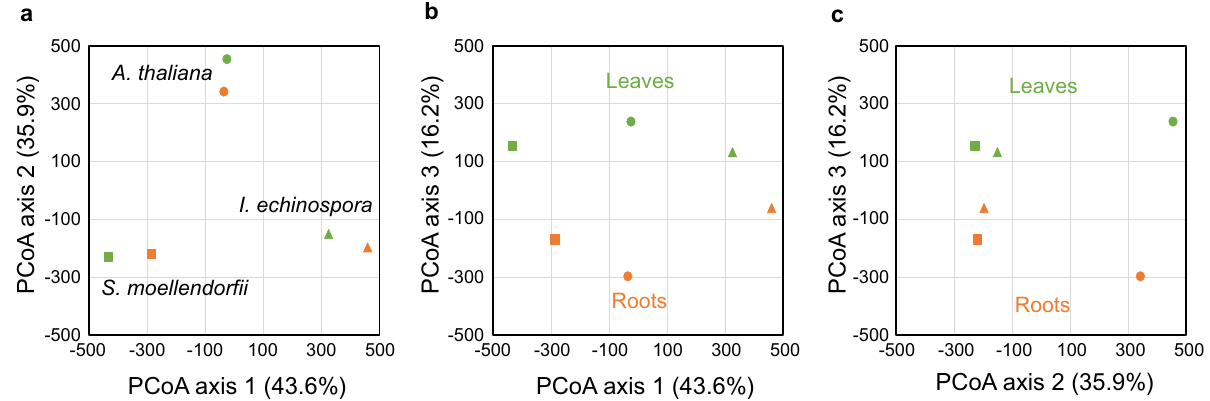
PCoA axis 1 (43.6%) Figure 3. Comparison of root and leaf transcriptomes of Arabidopsis thaliana , I. echinospora and Selaginella moellendorffii . Comparison of gene expression profiles by PCoA in the transcriptomes of A. thaliana, circles, S. moellendorffii, squares and I. echinospora, triangles. Leaf samples coloured green, root samples orange. ( a ) comparison of principal coordinate axis 1 and 2. ( b ) comparison of principal coordinates axis 1 and 3. ( c ) comparison of principal coordinate axis 2 and 3. Values in brackets on each axis describe the percentage of total variance accounted for by each axis. Axis 1 separates gene expression in the three species. Axis 2 distinguishes gene expression between the two lycophytes transcriptomes, I. echinospora and S. moellendorffii from A. thaliana. Axis 3 distinguishes between the leaf samples and the root samples in each (Supplementary Table S1). We searched the I. echinospora transcriptome for RSL genes using the BLAST algo- rithm with RSL-specific queries. RSL sequences were identified in the I. echinospora transcriptome. A gene tree was generated and defined four I. echinospora RSL genes in two monophyletic groups (Fig. 4). There were three transcripts in the RSL Class I clade (106204; 101034; 092963) and a single transcript in the RSL Class II clade (095243). We next investigated the expression of the I. echinospora RSL genes in the transcriptome, generated with single biological rootlet replicate. Average expression of the four RSL genes in rootlets was 4.24 transcripts